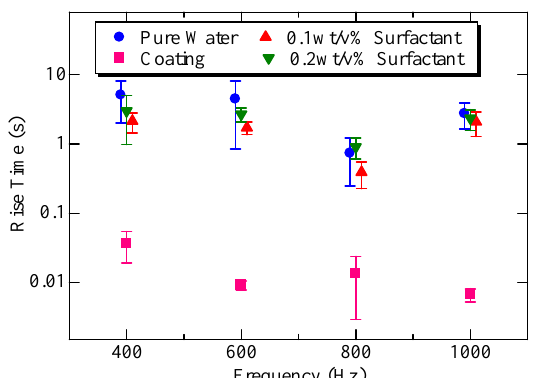
Figure 8. The relationship between the rise time and applied frequencies for four different hydrophilic treatments.